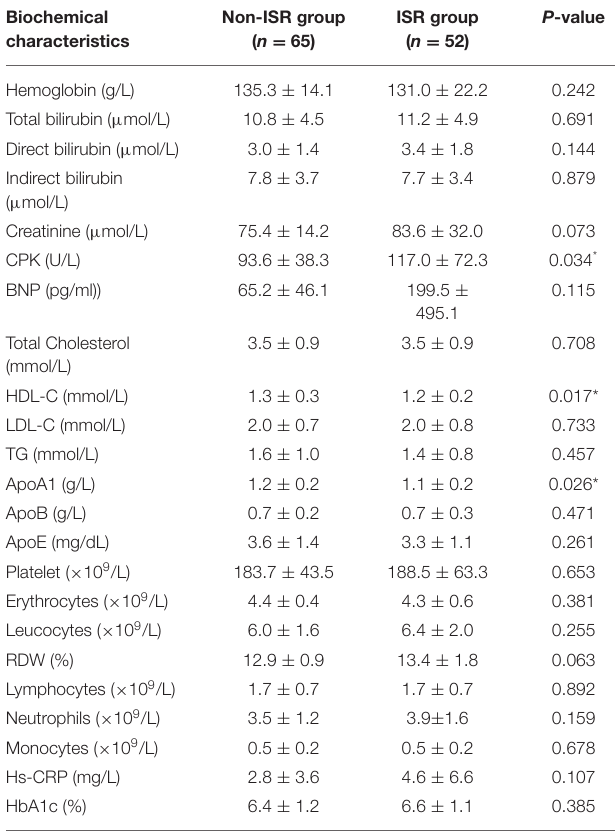
during the angiography. Biochemical